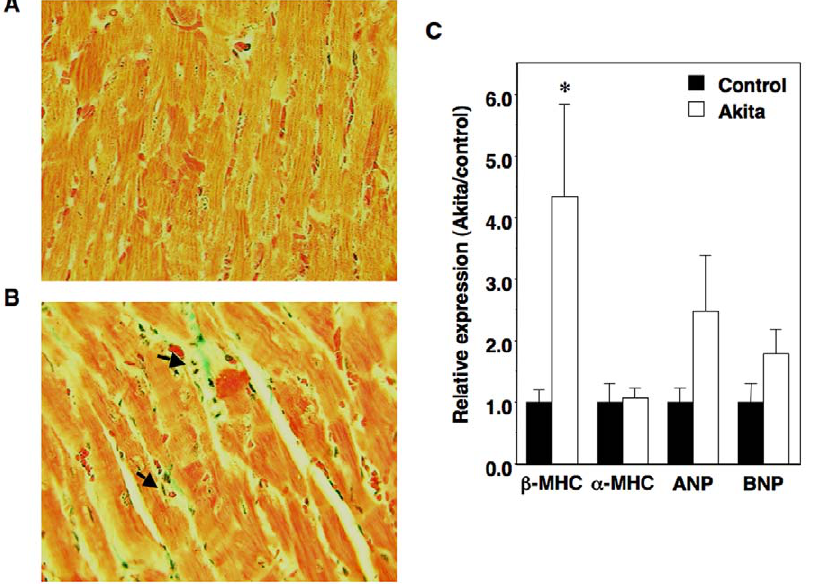
Figure 7. Cardiac injury in male Akita mice. (A–B) Panels A and B show representative photomicrograph of heart sections from controls (A) and diabetic mice (B) at 10 weeks of age. Examination of Akita mice hearts revealed mild interstitial fibrosis (green) and focal inflammatory infiltrates (arrows). Tissue sections were stained with Masson trichrome and the magnification was 400 6 . (C) Expression of mRNA for b -myosin heavy chain ( b - MHC) was enhanced in 10-week old Akita mice. Levels of mRNA were expressed relative to controls (assigned as 1.0) and normalized to b -actin mRNA level. Black bars=control (n=5); white bars=Akita (n=5). Data are mean 6 SEM. *P , 0.05 vs. age-matched controls.